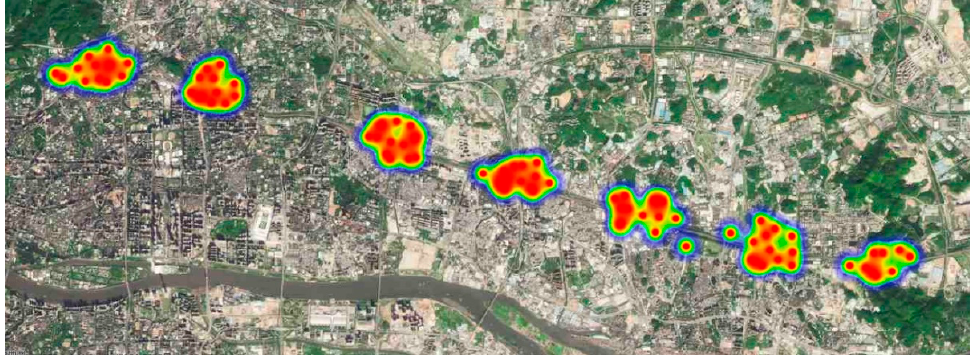
Figure 3. Thermodynamic diagram of the passenger travel demand at the major stations at 8:30.